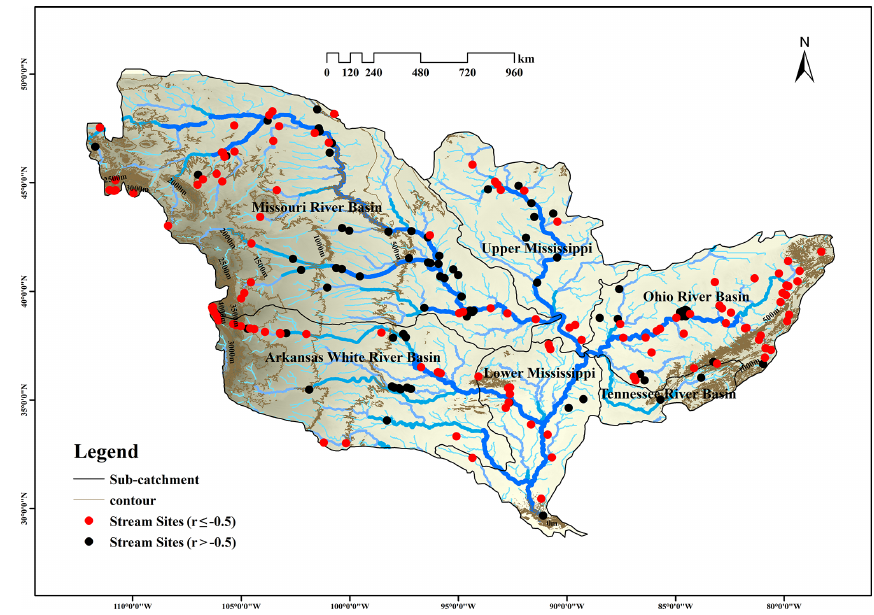
Figure 7. Ground elevation and spatial distribution of correlation coefficients for the correlation between stream conductivity and discharge in the Mississippi River basin.